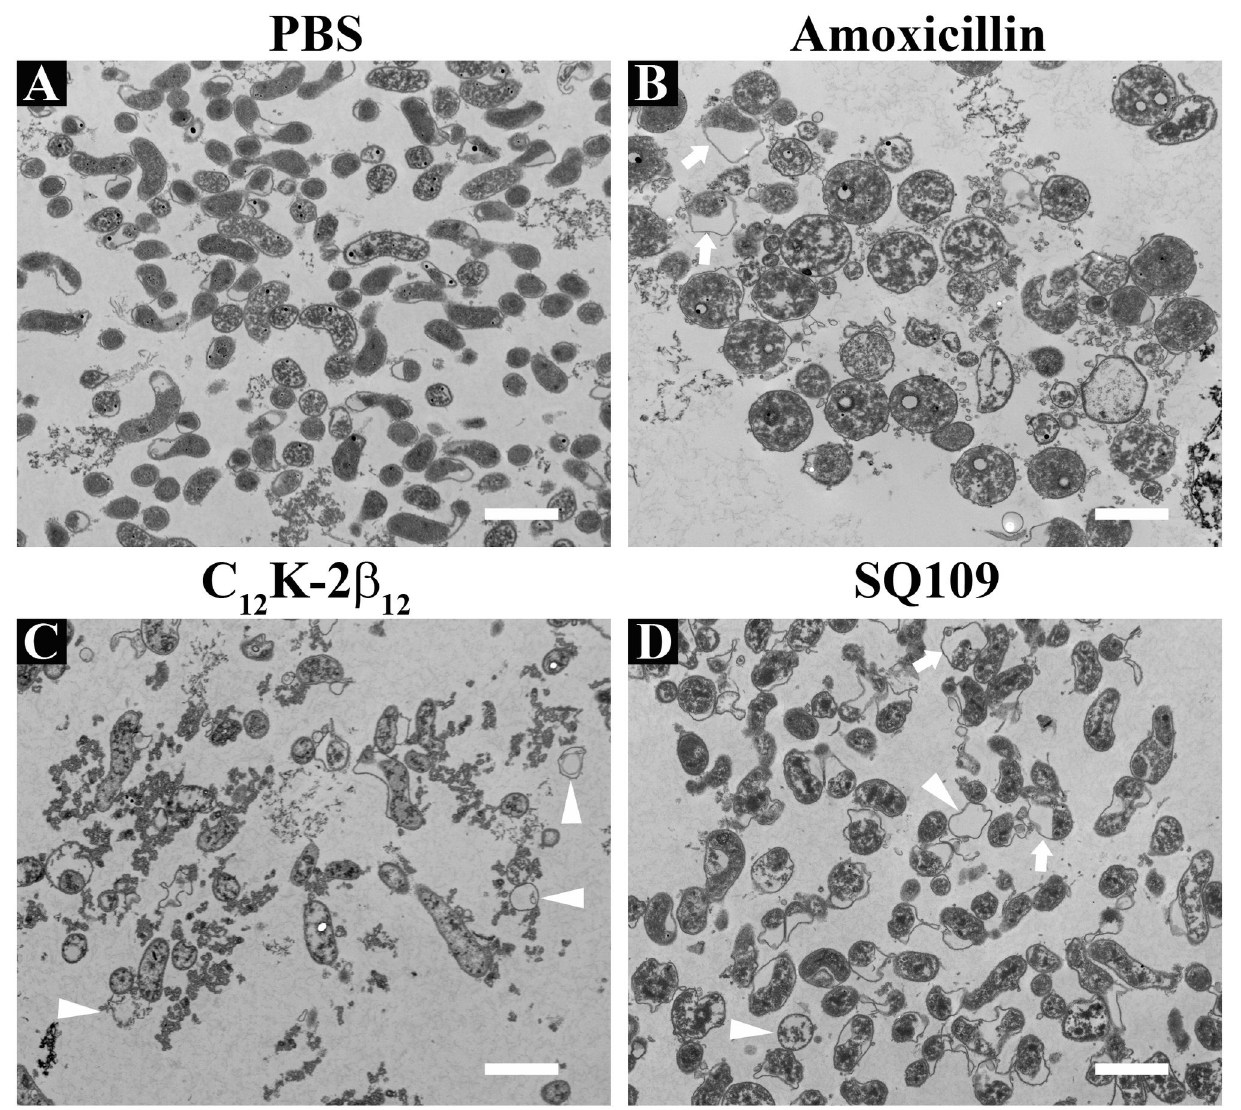
Figure 6. Visualization of SQ109-induced morphological changes of H. pylori using transmission electron microscopy (TEM). Approximately 6 x 10 7 H. pylori cells were sampled following 8 h of exposure to PBS ( A ), 100 µM amoxicillin ( B ), 20 µM C K-2β peptide ( C ) or 140 µM SQ109 ( D ). Cells were examined at low magnification (6,500x) on a TEM and images were acquired 12 12 and processed with AMT XR60B digital camera and AMTV600 software, respectively. ( A ) demonstrates normal spiral- or comma- shaped rod morphology of H. pylori cells as well as intact cell membranes following treatment with PBS as a negative control drug. Amoxicillin-treated cells ( B ) show characteristically swollen cells as well as detachment of the inner membrane from the outer membrane (white arrows). C K-2β -treated cells ( C ) show cell lysis, numerous ghost cells (C, white arrowheads) as well as the 12 12 formation of electron dense structures within the extracellular medium and inside the cells. Like AMX-treated cells, SQ109-treated cells ( D ) present with inner membrane detachment from the outer membrane (white arrows), but are not significantly enlarged. Some ghost cells are visible (white arrowheads). Scale bars = 1500 nm. The data are representative images from two independent